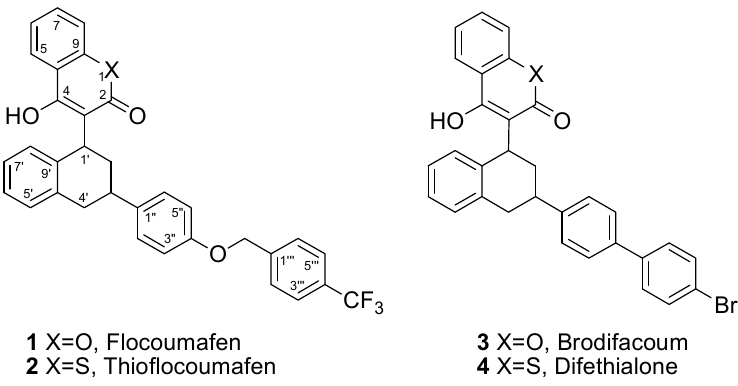
Figure 1. Structures of warfarin type anticoagulants 1 – 4